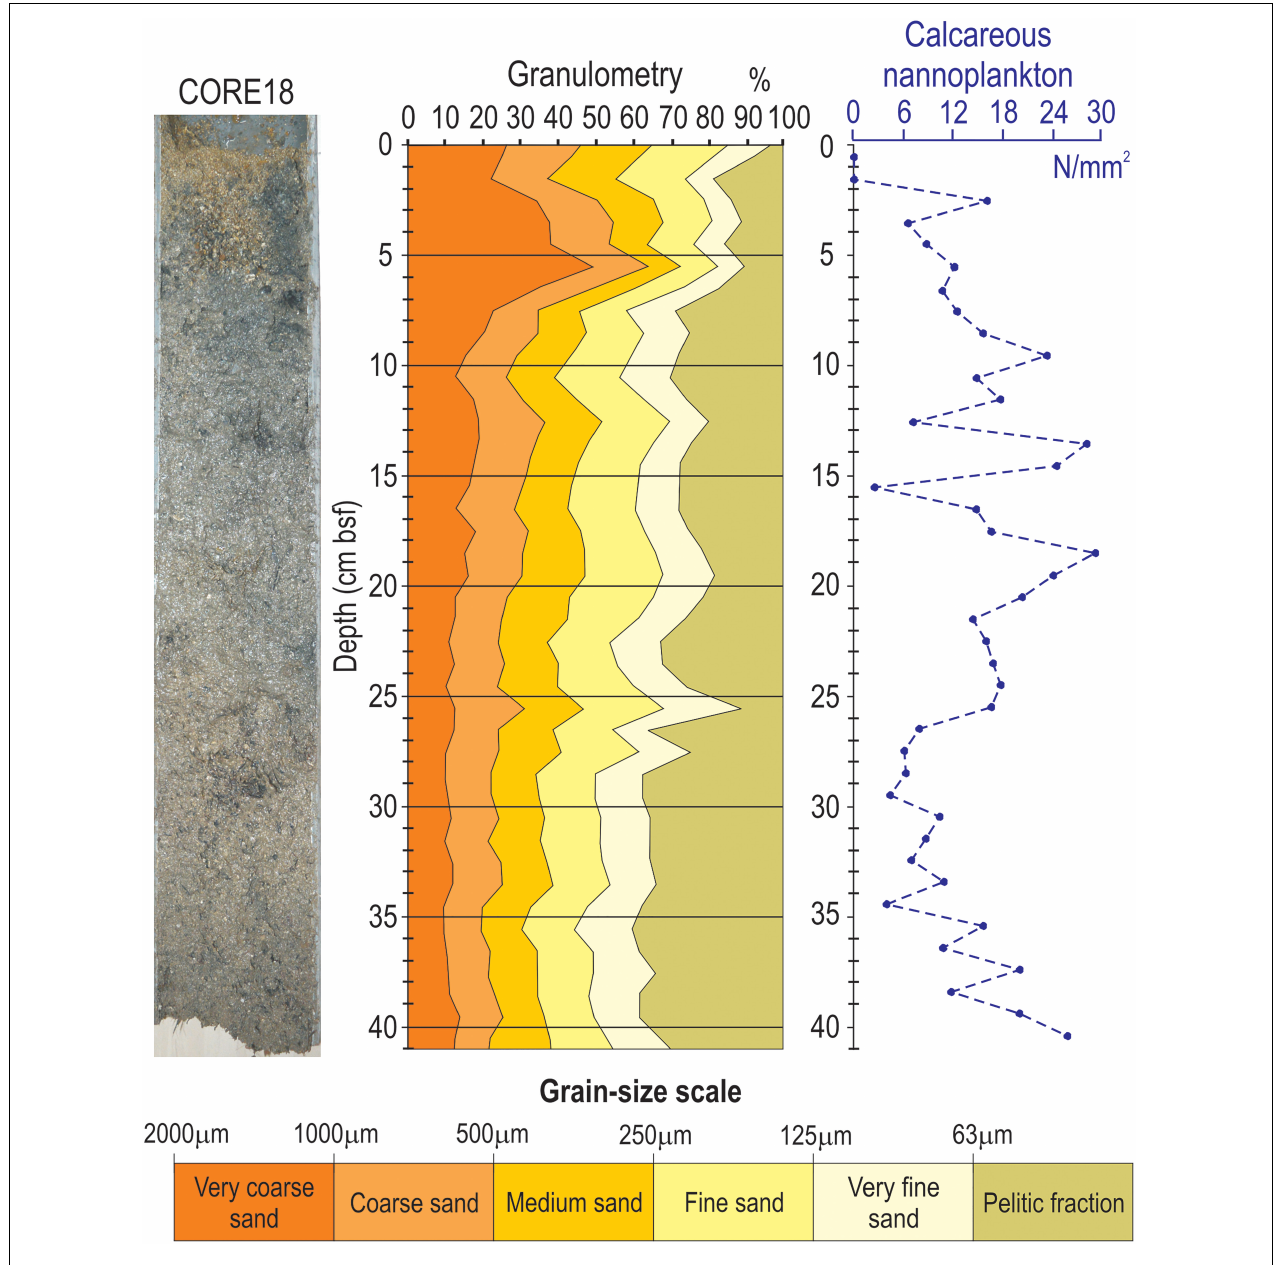
FIGURE 3 | From left to right: photo of CORE18, granulometric curves according to Blott and Pye (2012), and curve of absolute abundance of calcareous nannoplankton down core. The content of finest particles continuously recorded without abrupt variations along the core is mandatory in order to proceed with radiometric